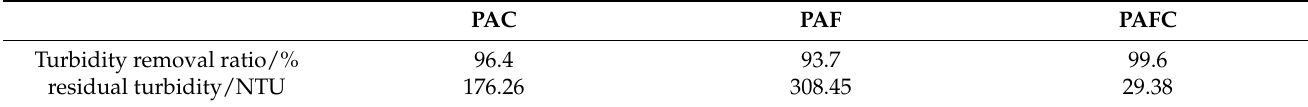
Table 2. Comparison of the effectiveness of PAFC, PAC, and PAF in treating mine water.